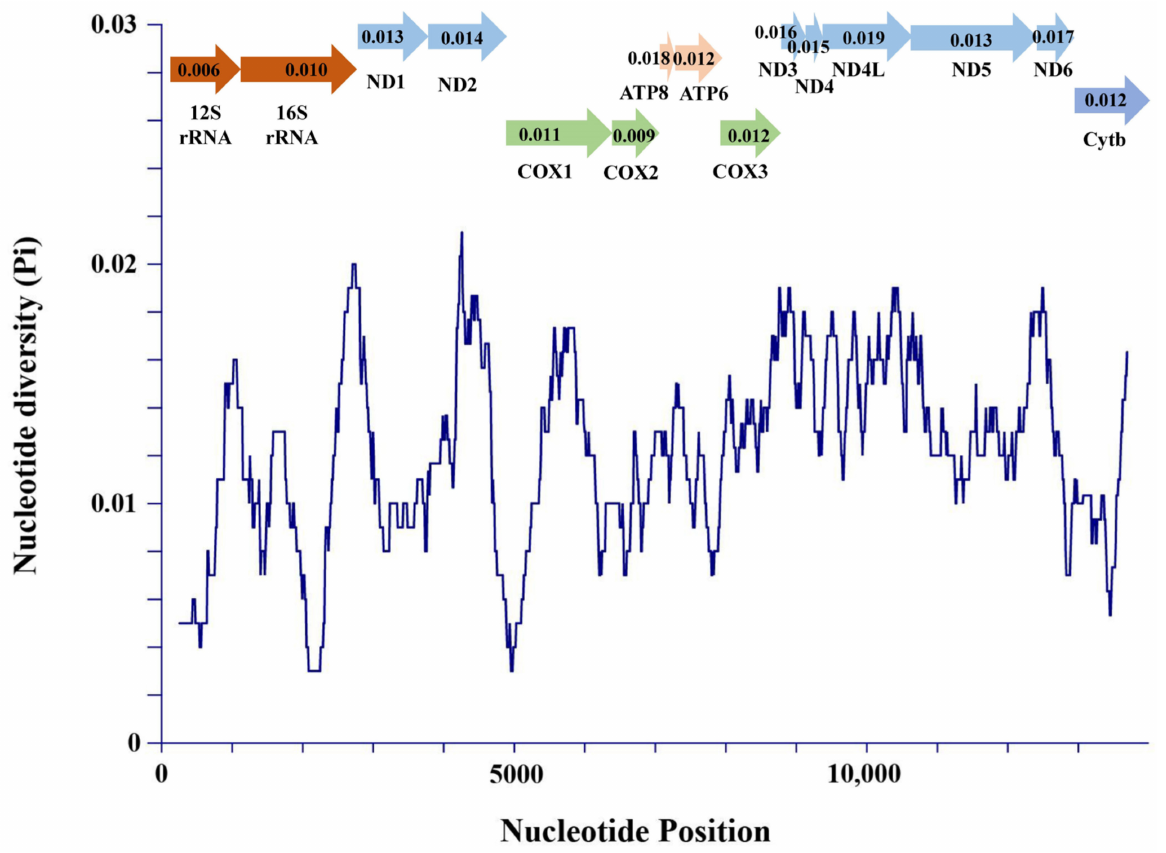
Figure 4. Sliding window analysis of 2 rRNA genes and 13 PCGs among the four P. sinensis